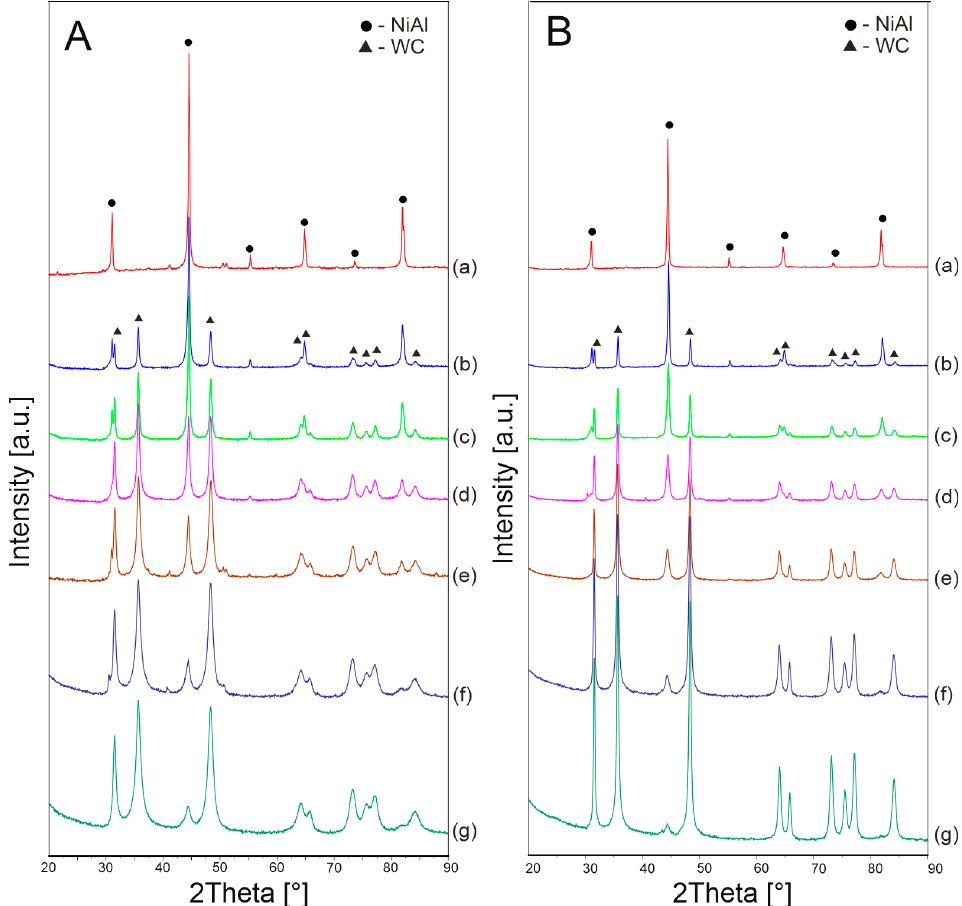
Figure 9. ( A ): XRD patterns of NiAl-800 (a), 10–800 (b), 20–800 (c), 40–800 (d), 60–800 (e), 80–800 (f) and 90–800 (g). ( B ): XRD patterns of NiAl-1100 (a), 10–1100 (b), 20–1100 (c), 40–1100 (d), 60–1100 (e), 80–1100 (f) and 90–1100 (g). The microstructure of the obtained composites is also affected by the lower (800 ◦ C) Table 5. Structural phase parameters and amounts determined by the Rietveld method collated with the planimetric phase estimation. be distinguished. For applied higher temperature regimes, porosity appears at the phase grain boundary region, which suggests its movement. Composites sintered at 800 ◦ C